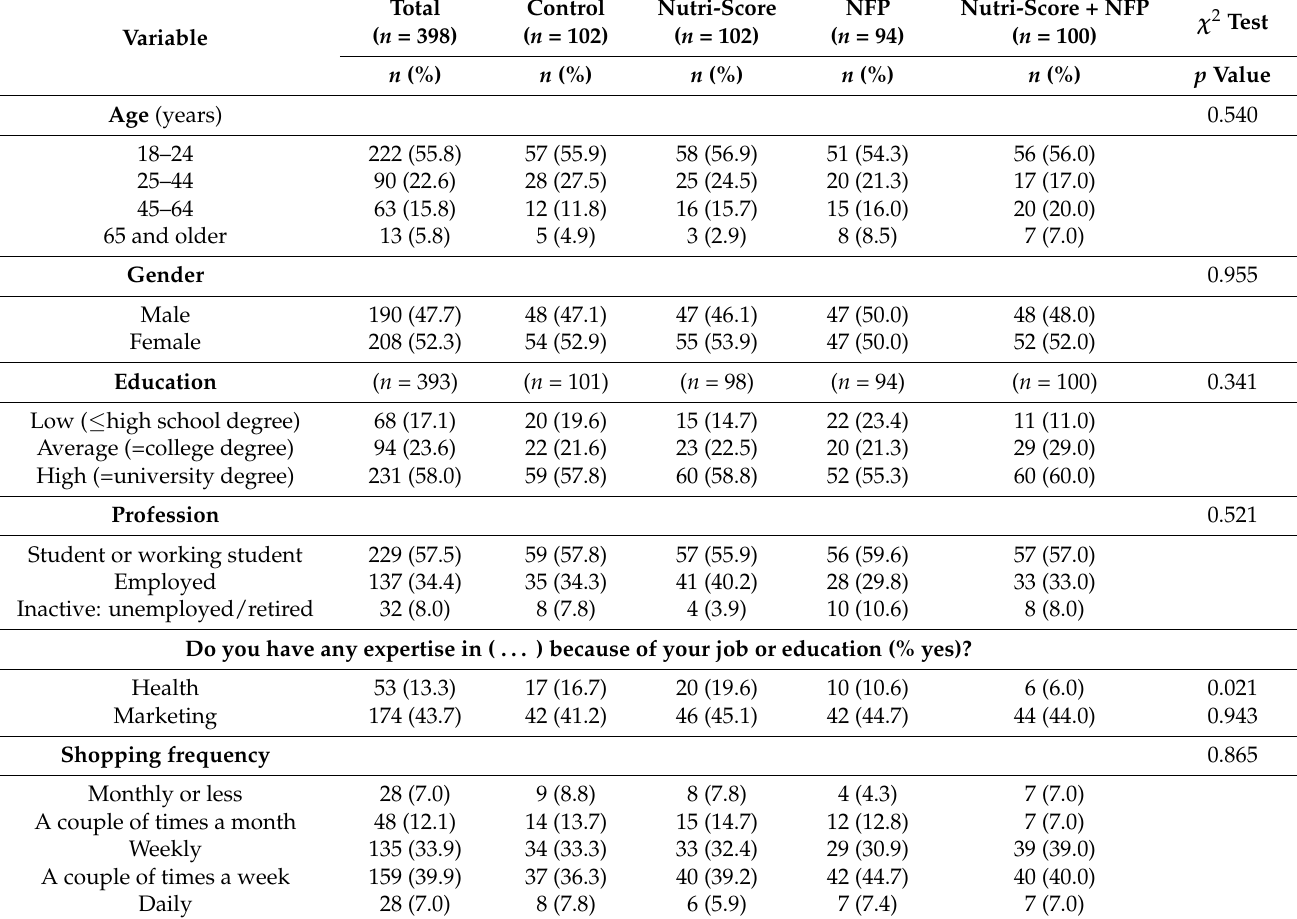
Table 2. Sociodemographic characteristics of the general sample (N =